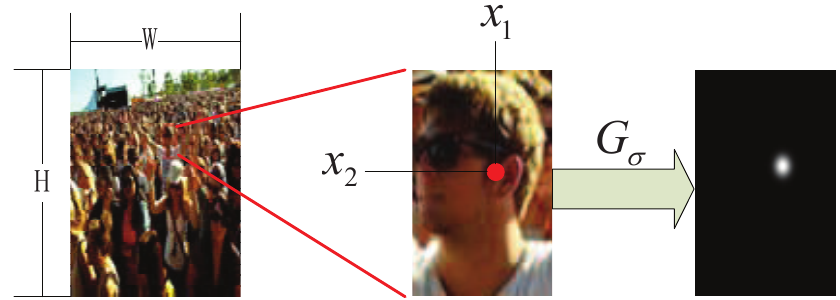
Figure 3: The process of generating density map with Gaussian